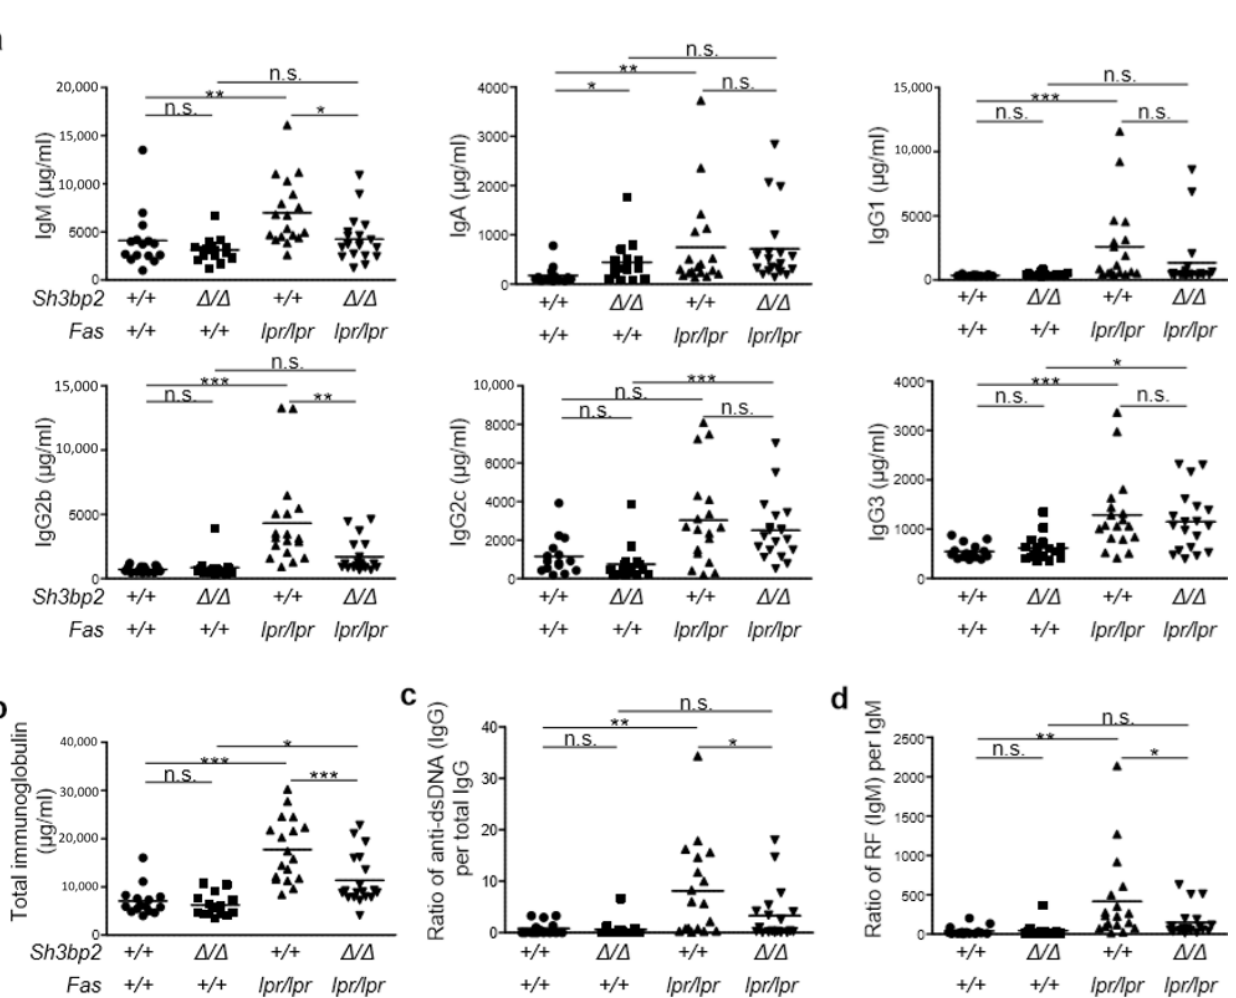
Figure A3. Immunoglobulin subclasses in the SH3BP2-deficient lupus mice. Serum samples were collected from Sh3bp2 +/+ ( n = 15), Sh3bp2 Δ / Δ ( n = 16), Fas lpr/lpr ( n = 18), and Sh3bp2 Δ / Δ Fas lpr/lpr ( n = 19) mice at 35 weeks of age. ( a ) Levels of each immunoglobulin subclass were determined by ELISA. ( b ) Total immunoglobulin levels were calculated by summing the concentrations of IgM, IgA, IgG1, IgG2b, IgG2c, and IgG3. ( c ) The ratio of anti-dsDNA antibody (IgG) per total IgG. ( d ) The ratio of rheumatoid factor (IgM) per IgM. Each dot denotes an individual mouse, and horizontal lines represent the means. * p < 0.05; ** p < 0.01; *** p < 0.001; n.s.= not significant.